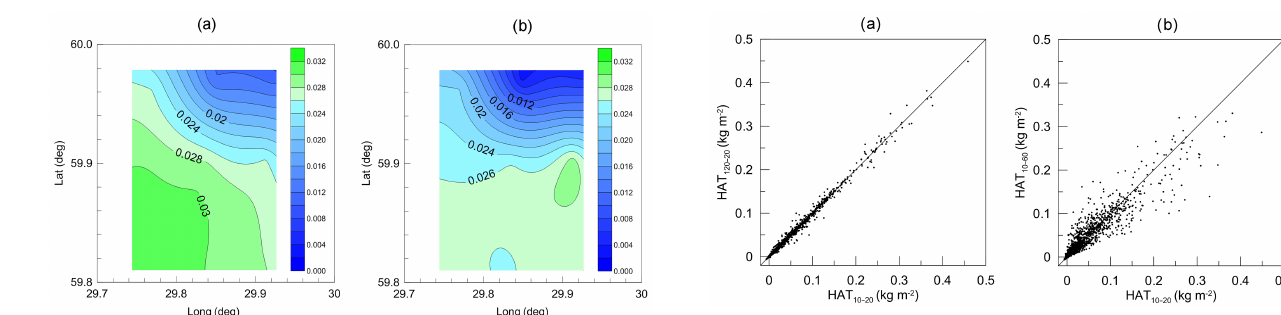
Figure 3. The map of the mean LWP values (kgm − 2 , colour scale) calculated for the small terrain and for the WH (a) and CD (b) data sets (measurements by the SEVIRI instrument).